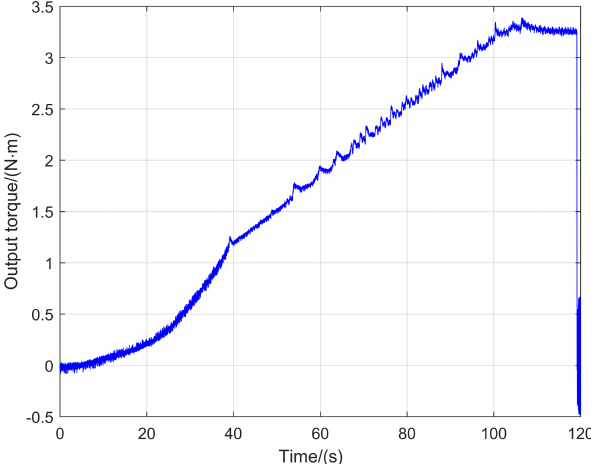
Figure 7. Test result of system driving